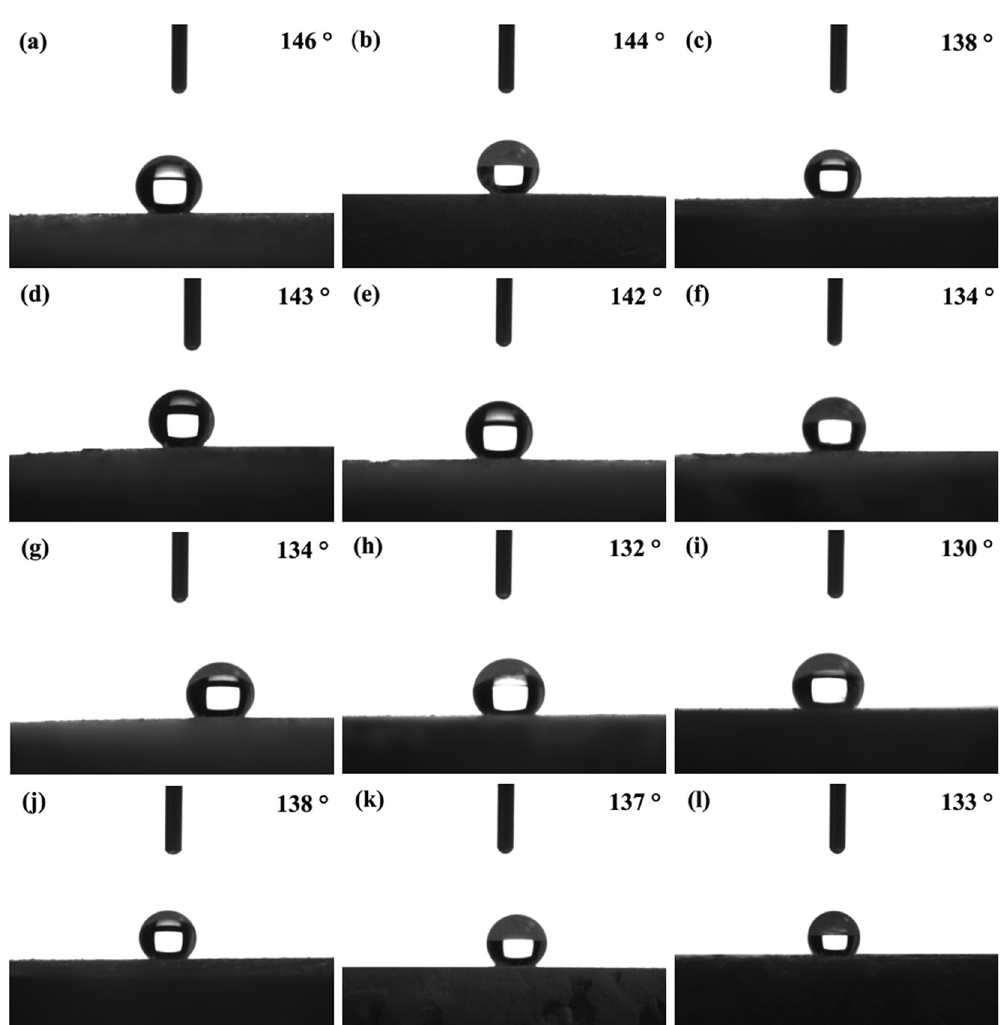
Figure A1: Water contact angle of BPSQ aerogels: ( a ) BTPB - 20 - 0, ( b ) BTPB - 20 - 0.25, ( c ) BTPB - 20 - 0.50, ( d ) BTPB - 15 - 0, ( e ) BTPB - 15 - 0.25, ( f ) BTPB - 15 - 0.50, ( g ) BTPB - 10 - 0, ( h ) BTPB - 10 - 0.25, ( i ) BTPB - 10 - 0.50, ( j ) BTB - 20 - 0, ( k ) BTB - 15 - 0, and ( l ) BTB - 10 -